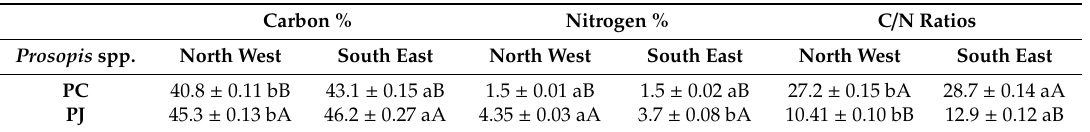
Table 4. Carbon and nitrogen contents and C / N ratio in leaves of Prosopis juliflora (PJ), and Prosopis cineraria (PC) at two canopy positions (south east, SE; north west, NW). Carbon % Nitrogen % C / N Ratios Prosopis spp. North West South